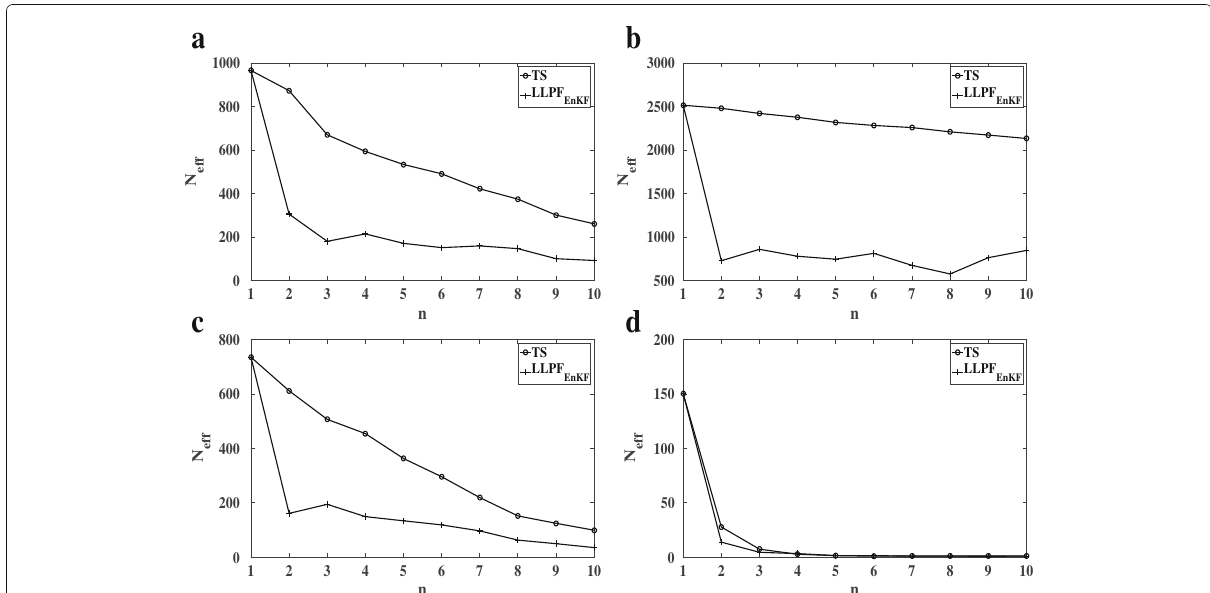
Fig. 8 Traceplots of average N eff , n of the TS and LLPF EnKF procedures based on N = 100 simulation experiments for Example 2 corresponding to four different ( Q , R ) specifications: a ( Q , R ) = ( 1,1 ) , b ( Q , R ) = ( 0.2,1 ) , c ( Q , R ) = ( 0.1,0.1 ) , and d ( Q , R ) = ( 0.05,0.1